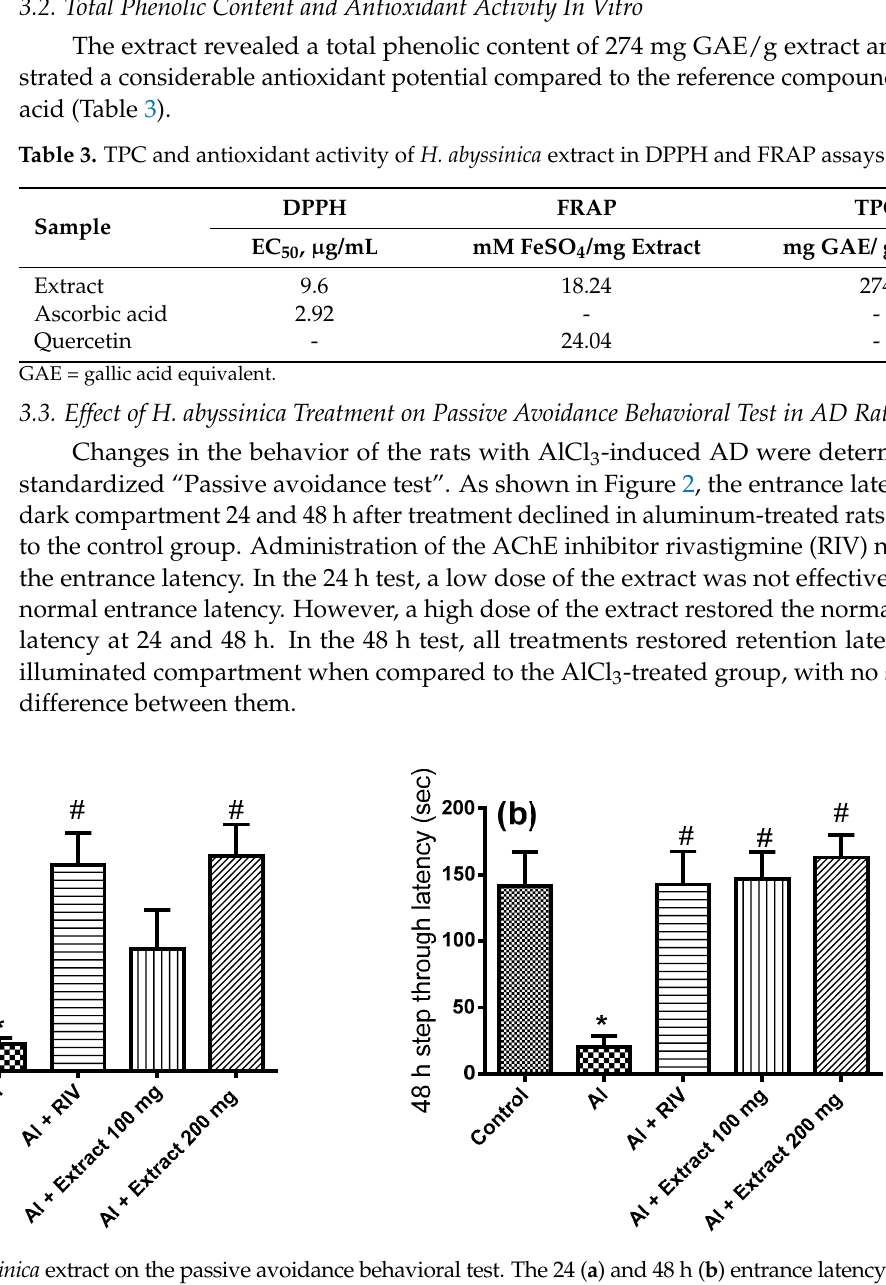
Figure 2. Effect of H. abyssinica extract on the passive avoidance behavioral test. The 24 ( a ) and 48 h ( b ) entrance latency to the dark compartment. * Significant difference from control group at p ˂ 0.001, # significant difference from AlCl 3 group at p ˂ 0.001.